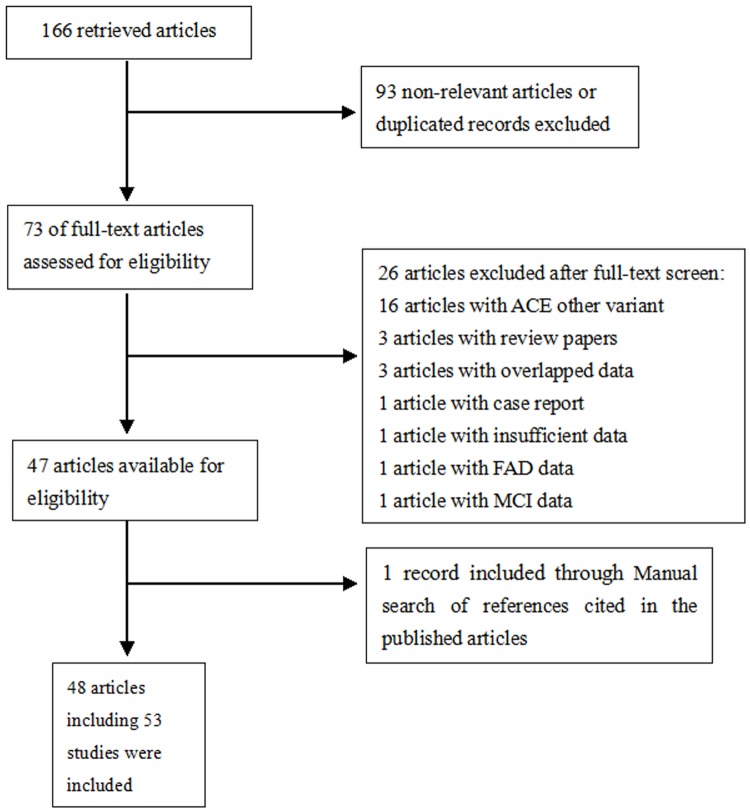
Flow chart of article selection in our meta-analysis.